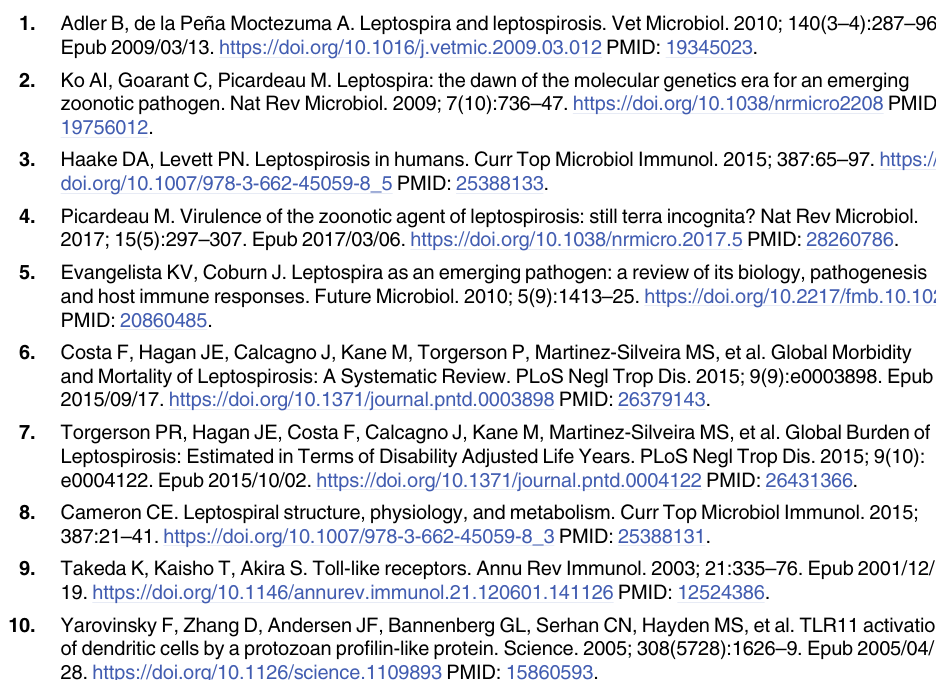
S1 Table. Significance of vaccine protection: Analyses by Fischer and Mantel Cox methods for significance of vaccine protection against the challenges in